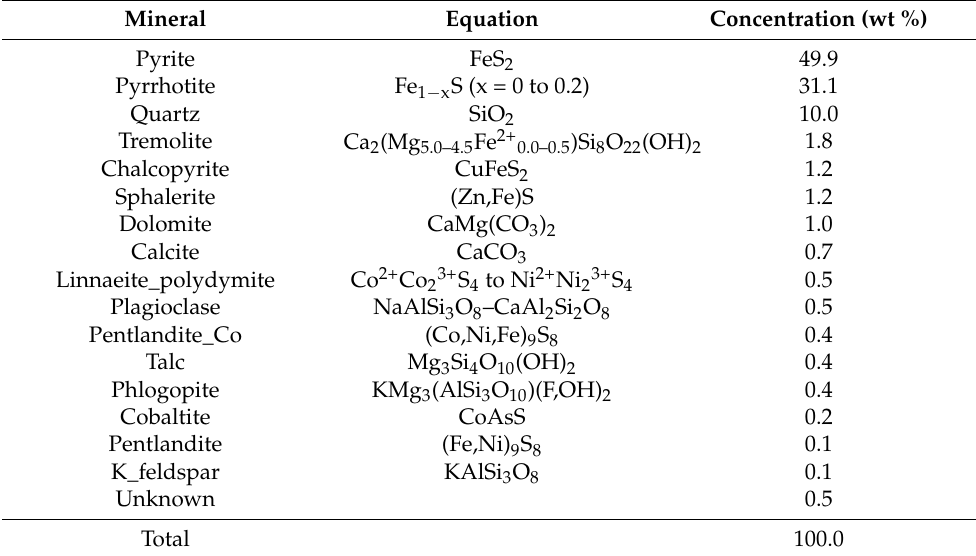
Table 4. Mineralogical composition of the sample (analyzed with MLA 600).